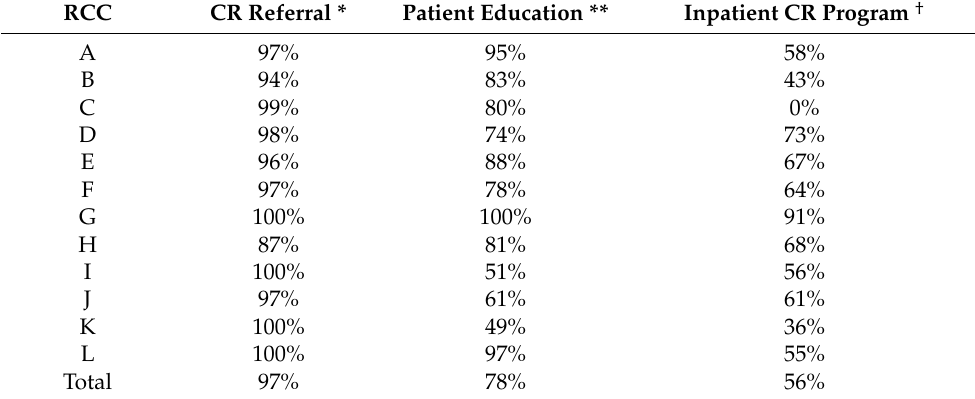
Table 7. Rate of CR Referral, Patient Education, and Inpatient CR Program in Each RCC.